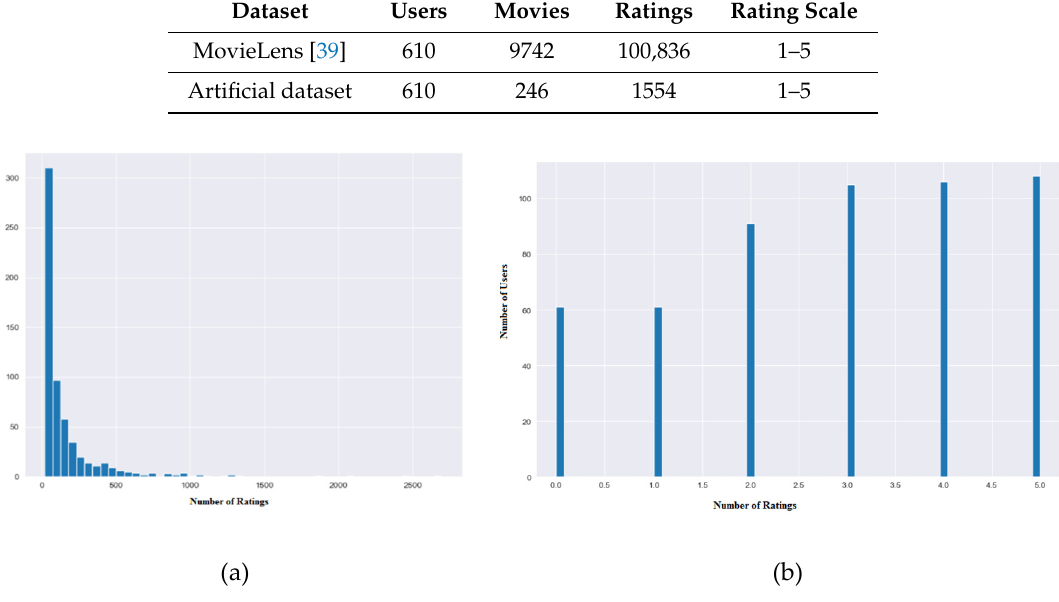
Table 12. Summary of mean absolute error (MAE) for various datasets